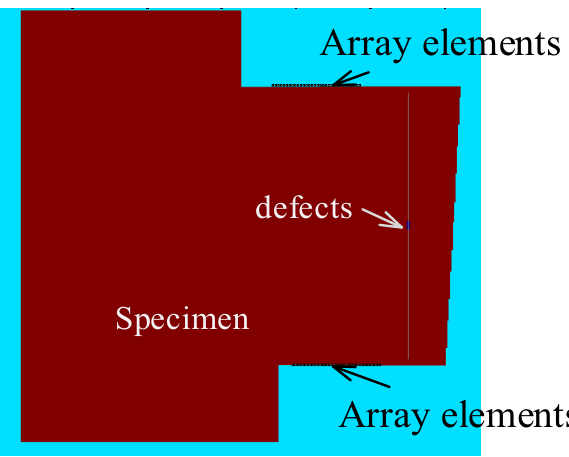
Figure 11. Array ultrasonic testing acoustic model of superalloy